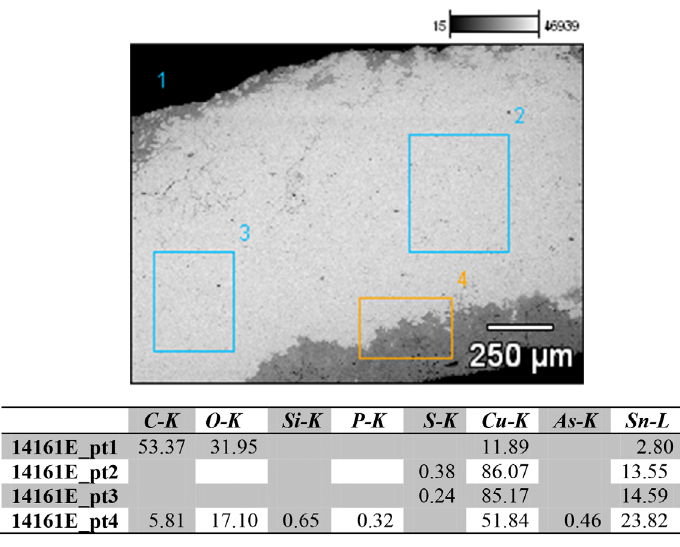
Figure 4. SEM analysis of the specimen sample from the end plate of the neck collar from Luttmissen, Uelzen (LMN 14161). The table lists the measured values of the individual measurements 1-4 (scan: Dirk Kirchner, German Mining Museum,